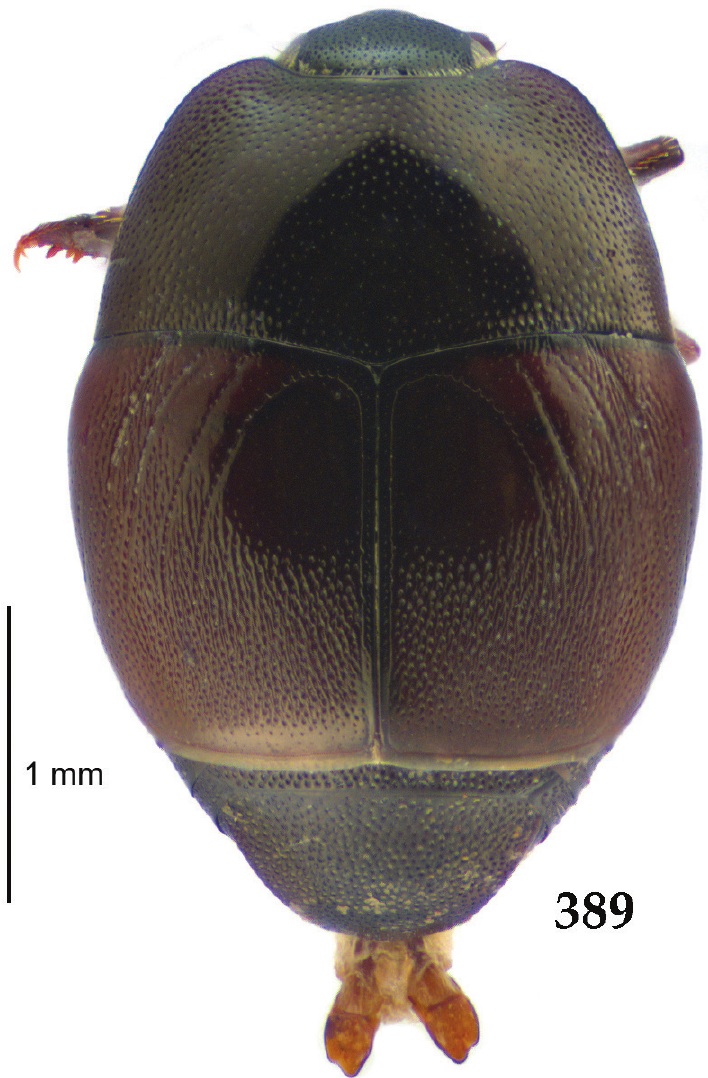
Figure 389. Saprinus ( Saprinus ) cupreus Erichson, 1834 habitus, dorsal view. 12.x.1991, T. Gush (under dead snake on the road) (ANIC); 3 specs., Hay Point, 21.17S 149.15E, 28.xi.1990, T. Gush (on dead kangaroo) (ANIC); 2 specs., Charter Towers, 5.iv.1965, Bornemisza-Yapp; 1 spec., Atherton, 26.iii.1965, Bornemisza (ANIC); 6 specs., Isla Gorge National Park, NE corner, 25°10'S, 150°01'E, 4.–6.iii.1998, D.J. Cook (vine scrub, dung pitfall) (QM); 1 spec., ditto, but 15.–19.xii.1997, 240 m; 1 spec., Mt. Rose, via Taroom, Site 2, 25°26'S, 149°59'E; 30.iii.1997, 200 m, D.J. Cook (at road-killed macropod) (QM); 2 specs., Brigalow Reservation Station Site 7,